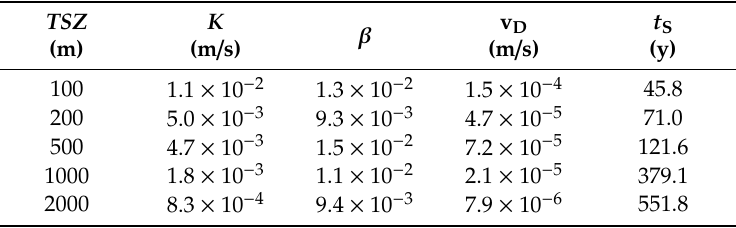
Table 1. The main results obtained from the Caposele aquifer modelling. TSZ, thickness of the aquifer’s saturated zone; K, hydraulic conductivity; β , water table slope; v D , Darcian velocity; t S , Darcian travel time to reach the spring